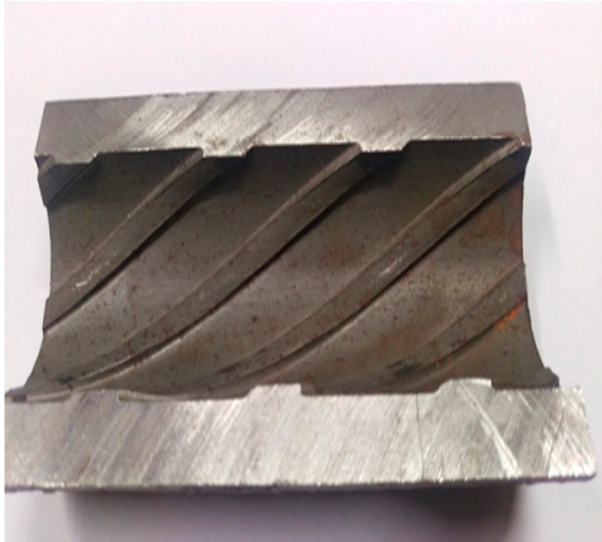
Figure 2. Cross ‐ section of the tube with internal helical ribs.